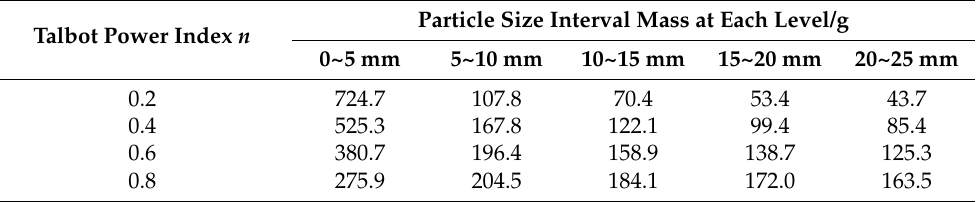
Table 1. Mass distribution of particle size of crushed gangue under continuous grading.